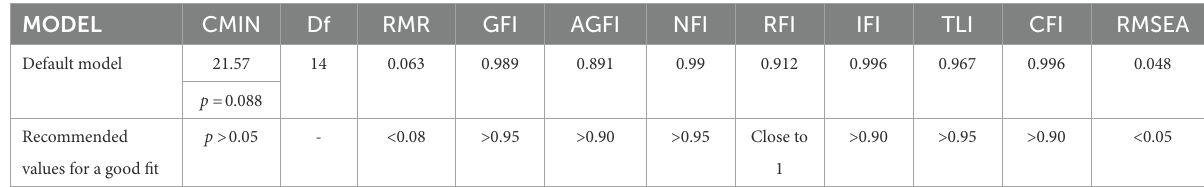
TABLE 6 The model fit summary.